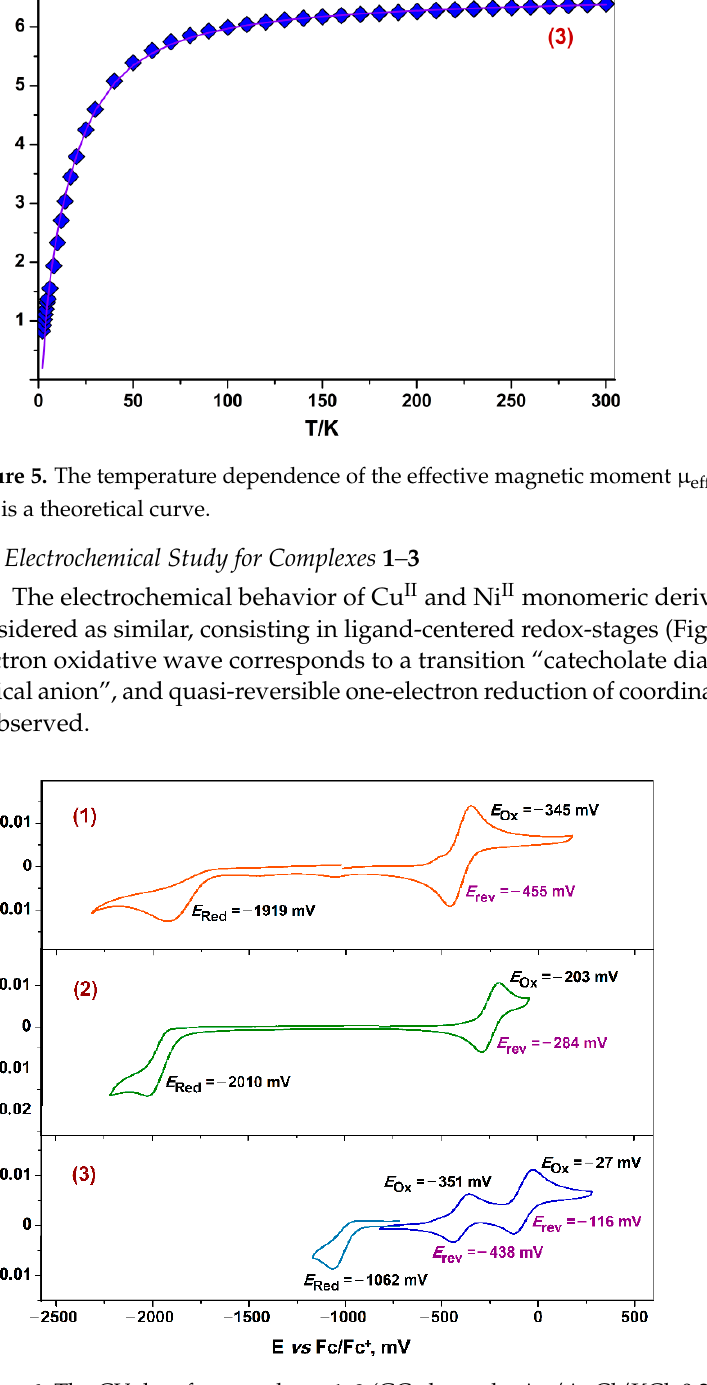
Figure 6. The CV data for complexes 1 – 3 (GC electrode, Ag/AgCl/KCl, 0.2 M Bu 4 NClO 4 , CH 2 Cl 2 , C = 2·10 − 3 mol/dm 3 , V = 0.2 V·s − 1 , Ar). Corrections to Fc/Fc + couple as a standard were made.